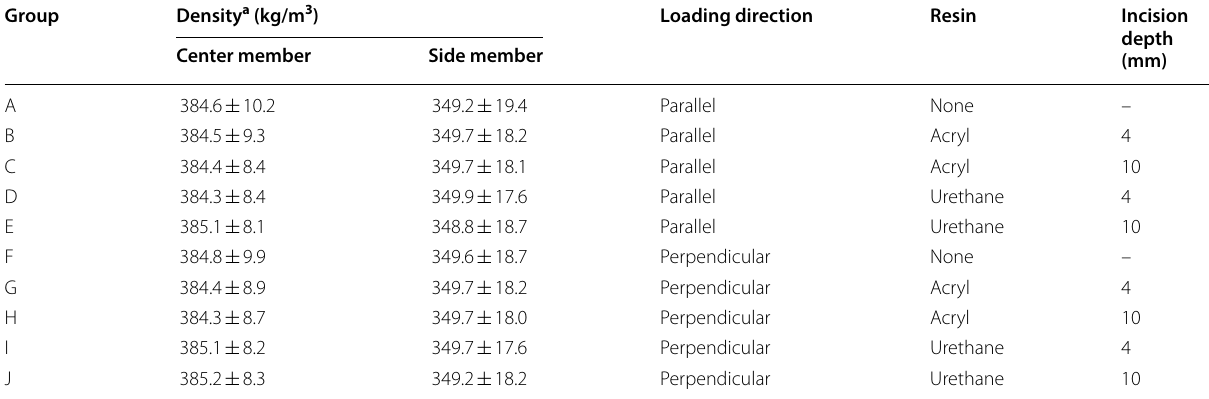
a The values mean average